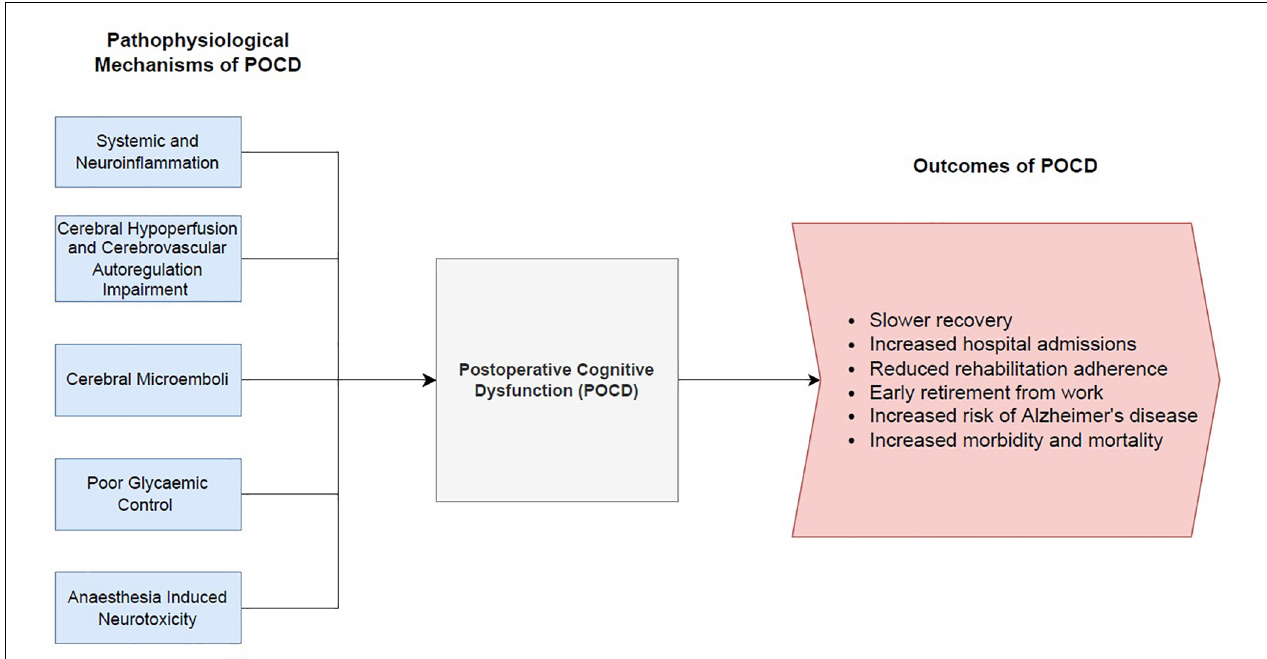
FIGURE 2 | Summary diagram of the pathophysiological mechanisms leading to post-operative cognitive dysfunction and the resulting outcomes of